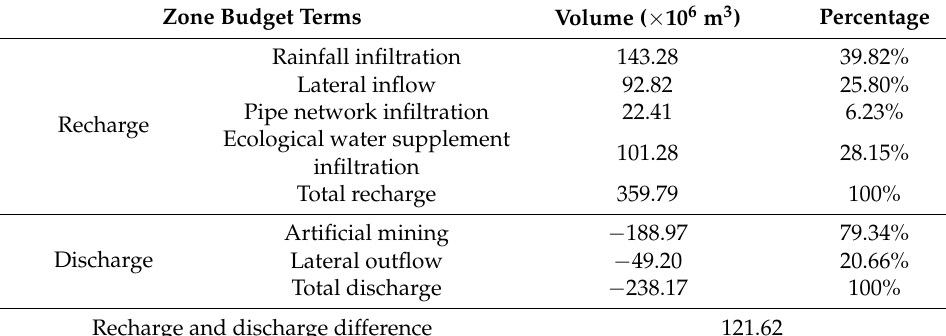
Table 2. Groundwater zone budget in the study area in 2019.